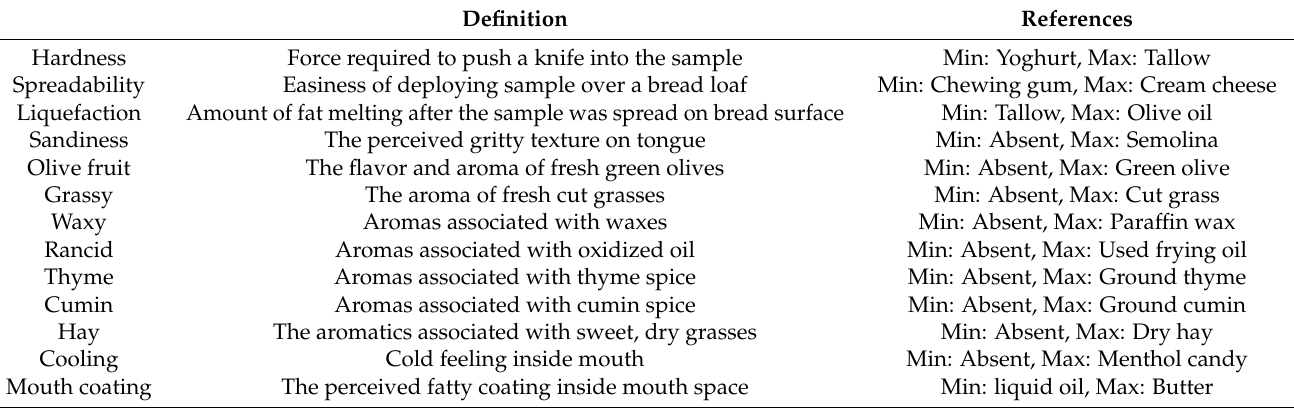
Table 6. The panel defined sensory descriptive terms, their definitions, and references